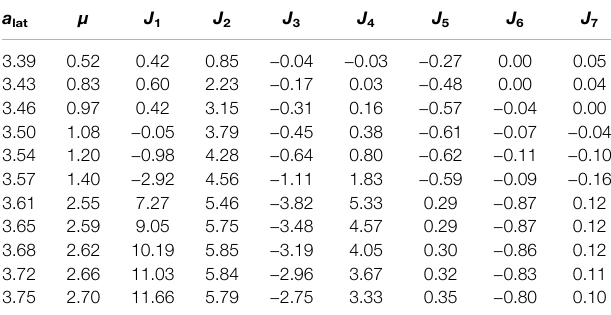
TABLE 4 | Input parameters extracted from DFT that are used in the SpiritCalculations for γ – Fe for different lattice constants a lat (given in Å). Listed arethemagneticmoment μ (in μ B perspin)andtheexchangecouplingparameters